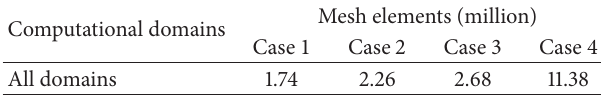
Table 2: Details of mesh elements.